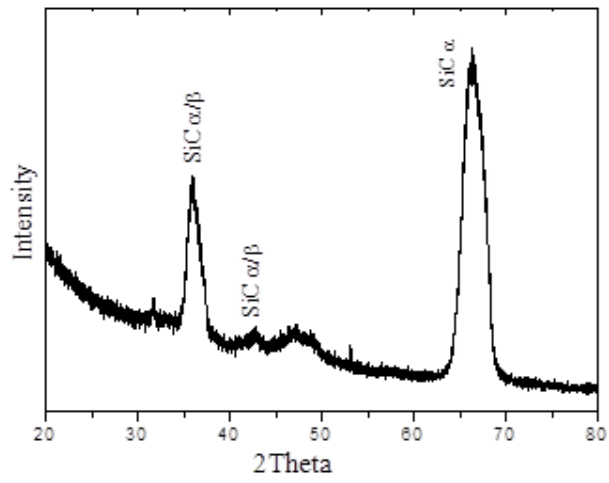
Figure 1. Grazing incidence x-ray diffraction spectrum of SiC film grown on AlN/Si(100) substrate.